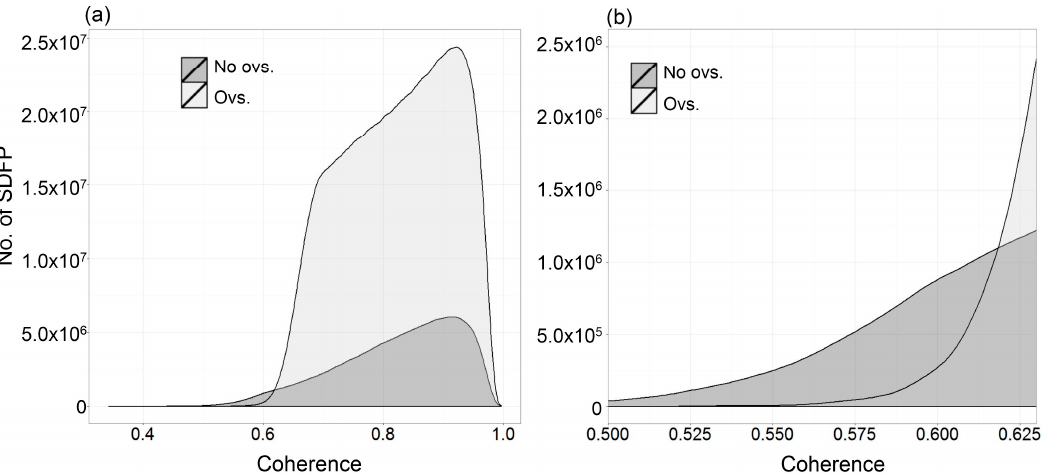
Figure 11. ( a ) Overlapped histogram of coherence distribution for all observed SDFP; ( b ) Histogram with adjusted visible coherence range of